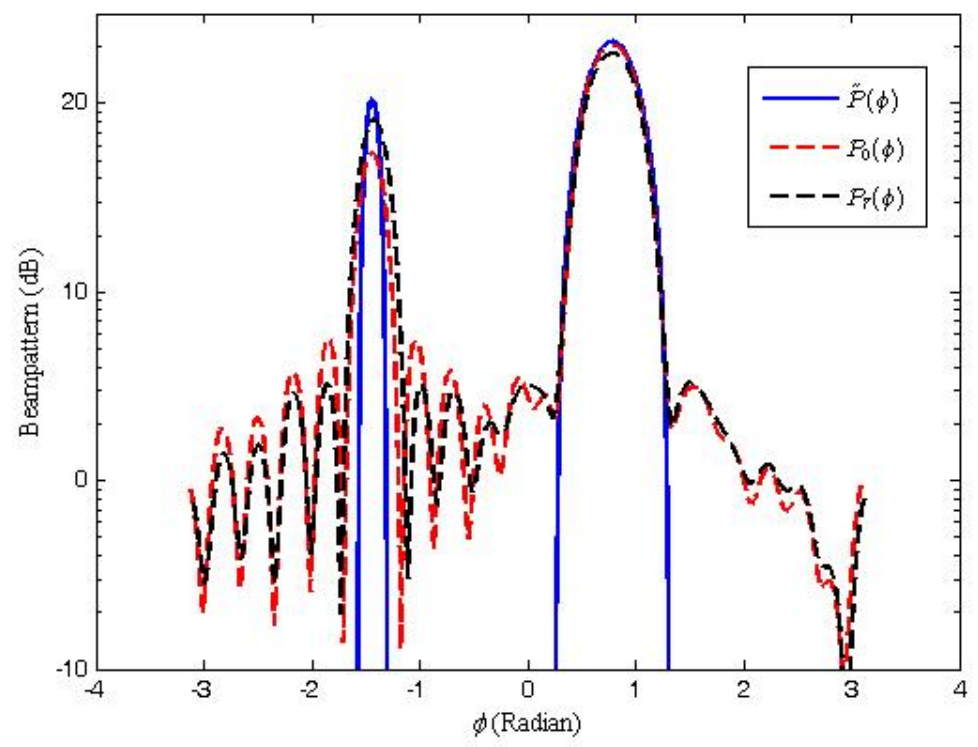
Figure 4. The desired beampattern vs. the transmit beampattern obtained using the cosine method 7 times ( M =